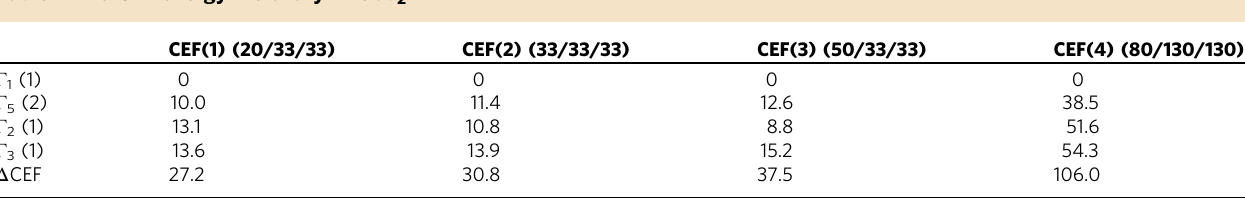
Table 1 The CEF energy hierarchy in USb 2